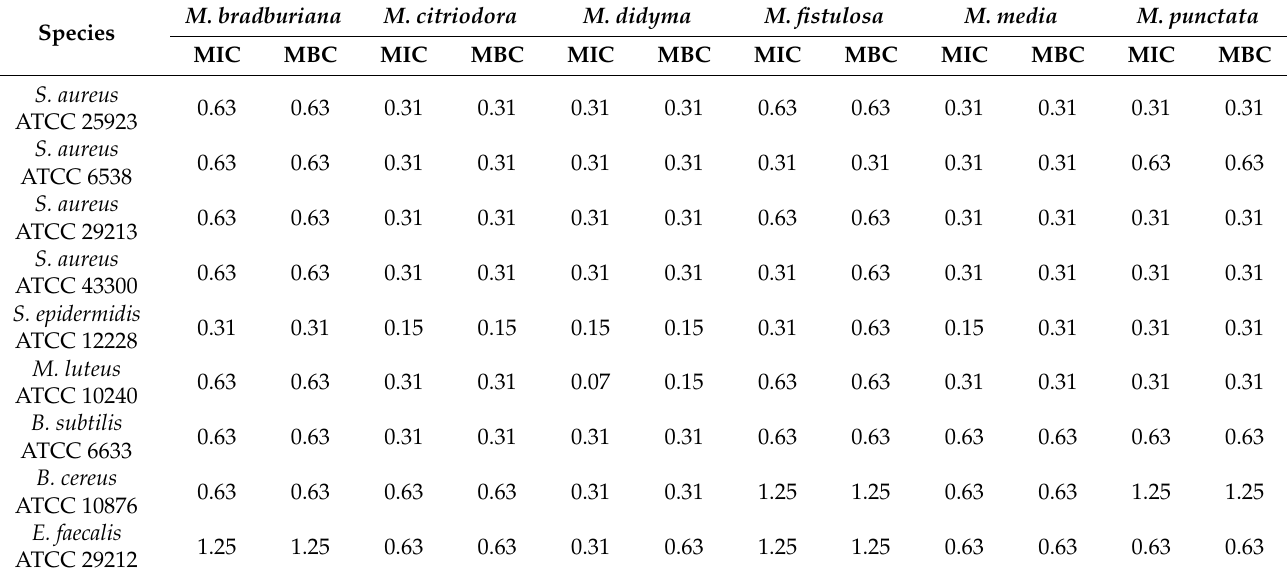
Table 3. Antimicrobial activity in vitro of 70% ( v/v ) methanolic extracts of Monarda species expressed as MIC and MBC (mg/mL) values against the reference strains of Gram-positive bacteria. The representative values (mode) are presented.